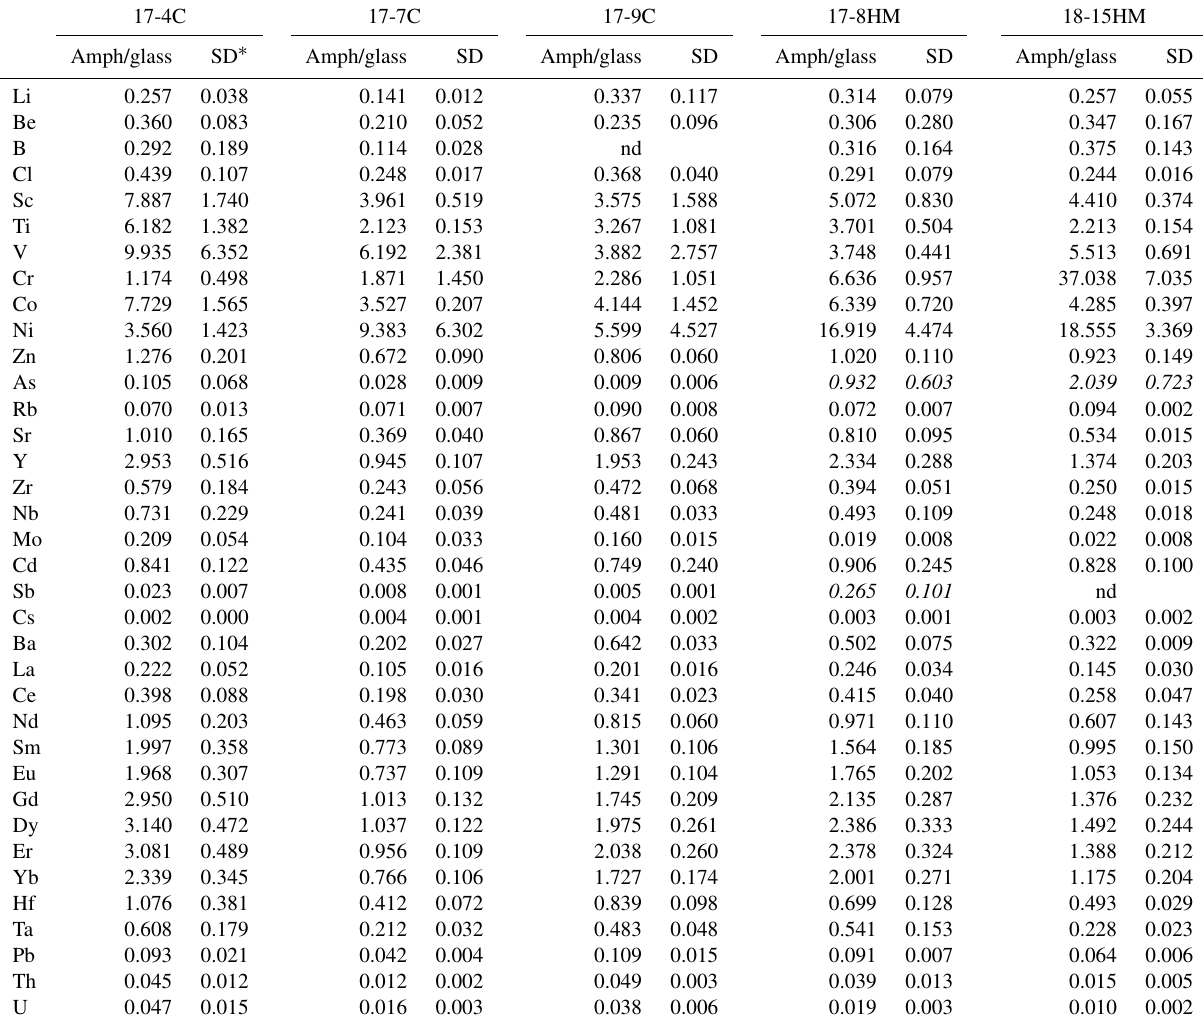
Table 5. Amphibole–glass partition coefficients calculated from LA-ICP-MS analyses of run products.